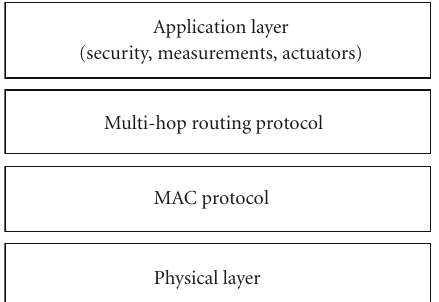
Figure 1: Hospital security WSN protocol stack. Security, measure- ments, and actuator control are implemented at the application level. The routing and the MAC protocol are designed for reliable low-latency multi-hop data forwarding. The physical layer consists of the hospital security WSN node hardware including various sensors.